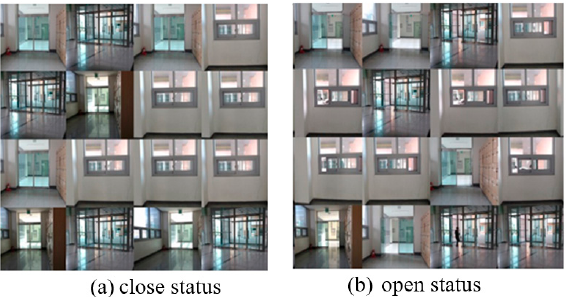
Figure 11. Images of windows and doors used in CNN Learning: ( a ) close status of doors and windows ( b ) open status of doors and windows.